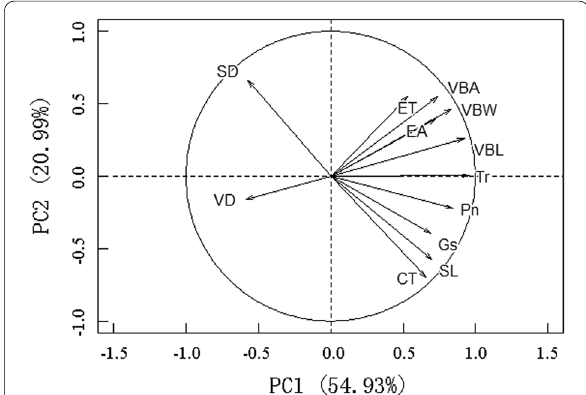
Fig. 2 Principal components analysis showing the contribution of hydraulic traits of Schoenoplectus tabernaemontani to total variance and the relationships among the characteristics. Pn net photosynthetic rate, Gs stomatal conductance, Tr transpiration rate, SL stomatal length, SD stomatal density, VD vein density, CT cuticle thickness, ET epidermal thickness, EA epidermal cell area, VBL vascular bundle length, VBW vascular bundle width, VBA vascular bundle area